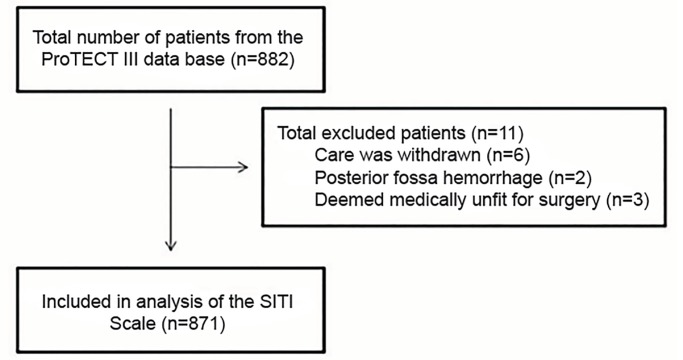
Flowchart of retrospective patient selection from the ProTECT III database.ProTECT III, Progesterone for the Treatment of Traumatic Brain Injury III Trial; SITI, Surgical Intervention for Traumatic Injury.